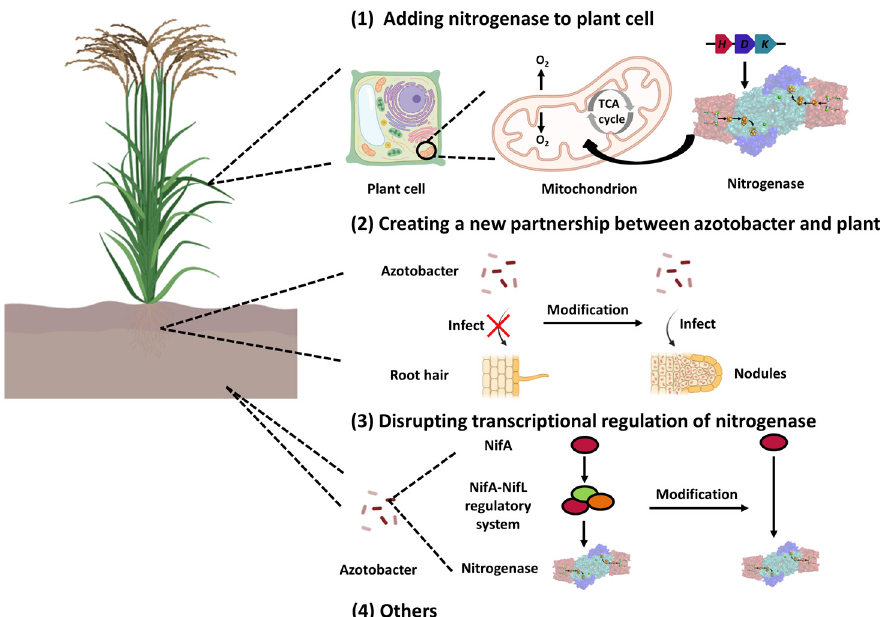
Figure 5. The strategy of engineering nitrogen fixation. ( 1 ) Adding nitrogenase into plant cells. Nitrogenase requires a lot of energy and a low–oxygen environment to execute the nitrogen–fixing function. The mitochondrion provides a suitable place to accommodate the enzyme. ( 2 ) Creating a novel partnership between azotobacter and plants. Under natural conditions, non–symbiotic azotobacter are not capable of infecting crops. Several key modifications, such as expressing rhizopine in the crop cells and the receptor of rhizopine in azotobacter, can specifically allow crops to recognize azotobacter. The elongated root hair can create a tunnel for azotobacter to infect the root hair and form nodules. ( 3 ) Disrupting the transcriptional regulation of nitrogenase. As the transcriptional regulation of nitrogenase is the crucial rate–limiting step in nitrogen fixation, several modifications can disrupt the original regulatory pathways, allowing them to evolve in ways beneficial to agricultural development. ( 4 ) Other